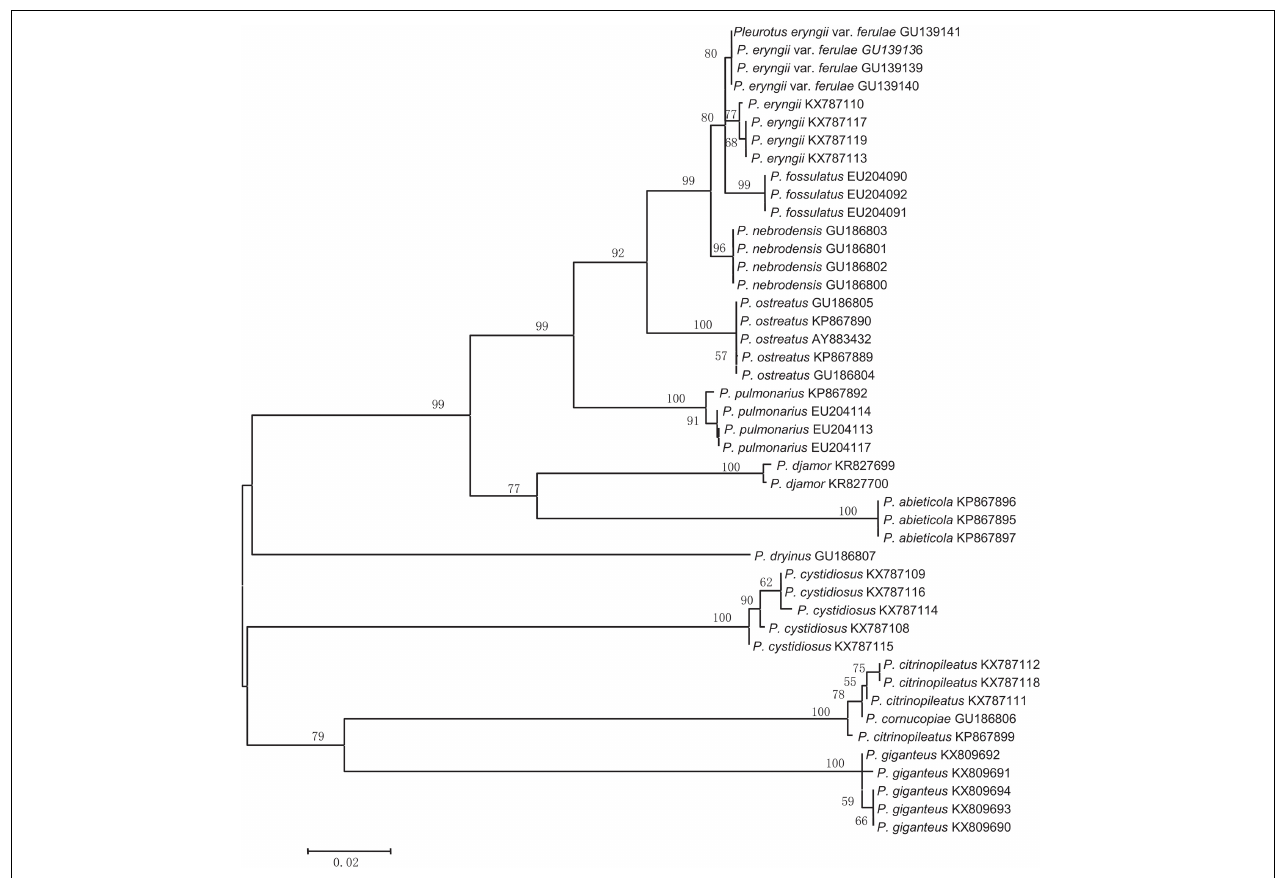
FIGURE 4 | Neighbor-joining tree based on the EF-1 α gene sequences from the Pleurotus